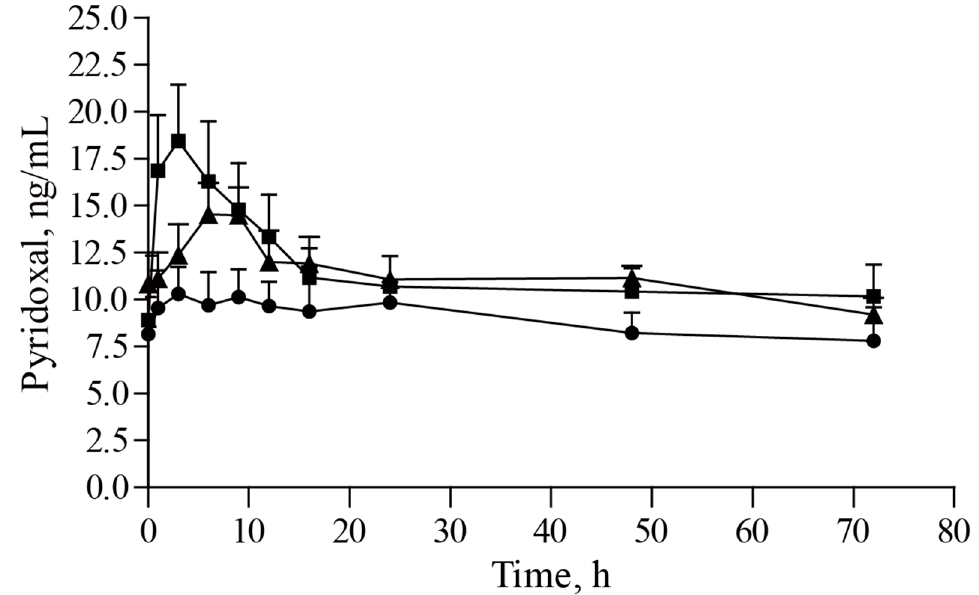
Figure 8. The plasma concentration of pyridoxal versus time. The concentration of pyridoxal in plasma from 0 to 72 h after oral placebo ( ● ), non-microencapsulated vitamin supplement ( ▪ ), and microencapsulated vitamin supplement ( ▲ ), respectively. Error bars represent standard deviations.